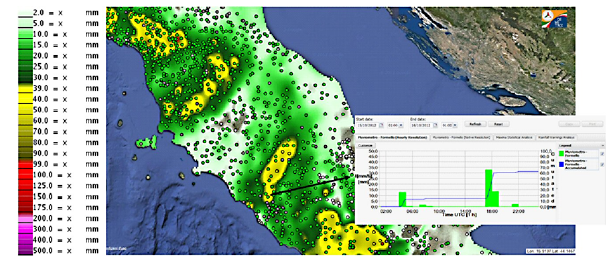
Figure 10. Reflectivity images at different times (17:00, 17:30 and 18:00UTC) collected by Polar 55C radar in Rome during 15 Octo- ber 2012 (elevation 1.6 ◦